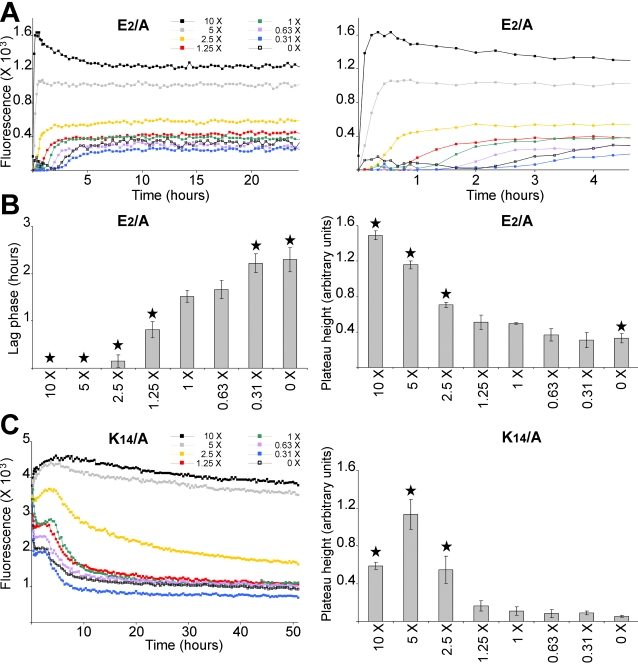
Effect of ionic strength on the fibrilization properties of mutant peptide with unstable amyloid products.Mutant peptide E2/A (50 µM) (A and B) or K14/A (100 µM) (C) were incubated with 165 µM ThT in 1.8 mM KH2PO4 and 10.1 mM NaH2PO4 with varying concentration of NaCl and KCl. The concentrations of NaCl and KCl were respectively: 0 and 0 (0 X), 42.8 mM and 0.84 mM (0.31 X), 85.6 mM and 1.7 mM (0.63 X), 136.9 mM and 2.7 mM (1 X), 171.1 mM and 3.4 mM (1.25 X), 350 mM and 6.7 mM (2.5 X), 700 mM and 13.5 mM (5 X), and 1.4 M and 27 mM (10 X). Changes in ThT fluorescence were monitored (A, with the right panel showing a scale-up of the left panel to visualize the rapid fibrilizations; and C). The lag phase of fibrilization (B, left panel) and plateau height (B, right panel; and C, right panel) are depicted. A black star signifies p<0.02 (B, left panel) and p<0.03 (B, right panel; C, right panel) when compared to 1 X NaCl and KCl.